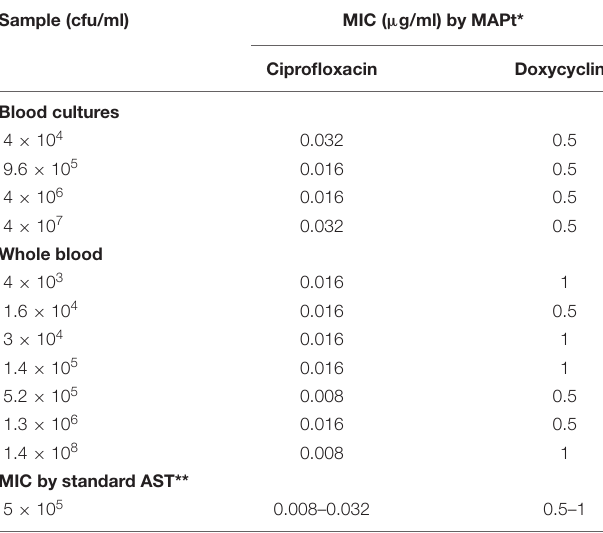
TABLE 4 | MIC values for gentamicin obtained by MAPt of blood cultures and whole blood samples inoculated with Y. pestis .